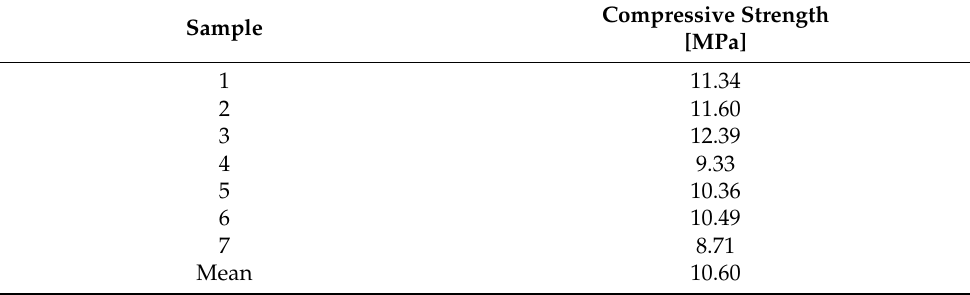
Table 4. Mean compressive strength values of the extracted mortar samples from the constructed wallettes.